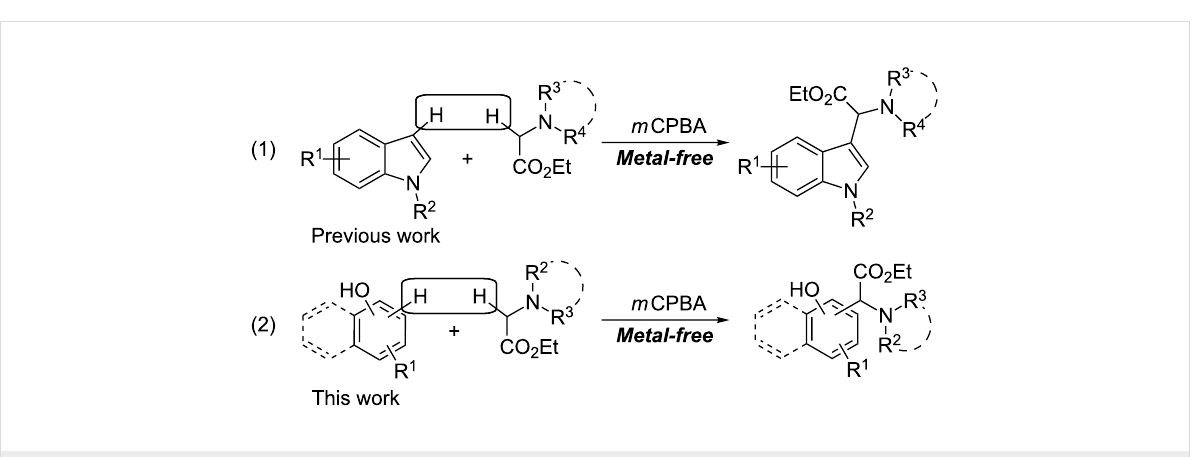
Scheme 2: Oxidative sp 3 C–H functionalization of α -amino